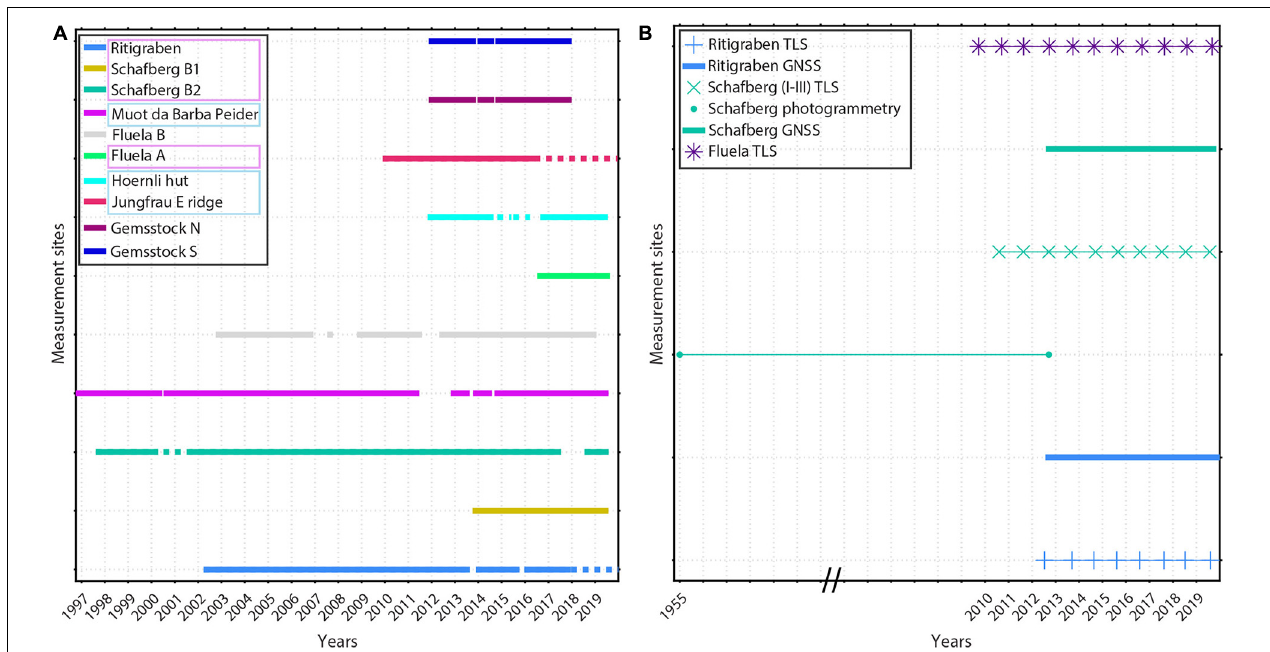
FIGURE 2 | Overview of the data availability at the measurement sites. In (A) the continuous borehole ground temperature measurements are shown. Dotted lines denote that some data is missing, but not in all depths. The coloured frames indicate the ice content of the boreholes: pink for ice-rich, light blue for ice-poor, and no frame for permafrost-free locations. In (B) yearly observations with TLS and continuous data observations using GNSS are shown for the ice-rich rock glacier sites. At Schafberg data between 1955 and 2012 originates from swisstopo airborne images (photogrammetry). Please note that the x-axis scale is not linear between 1955 and 2012, as indicated by the two